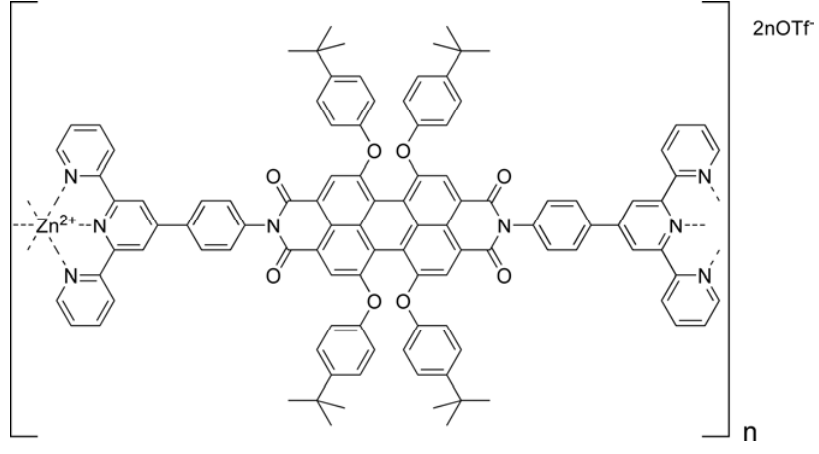
Figure 6. Complexation between 2,2 ′ :6 ′ ,2 ′′ -terpyridine derivatives and Zn 2+